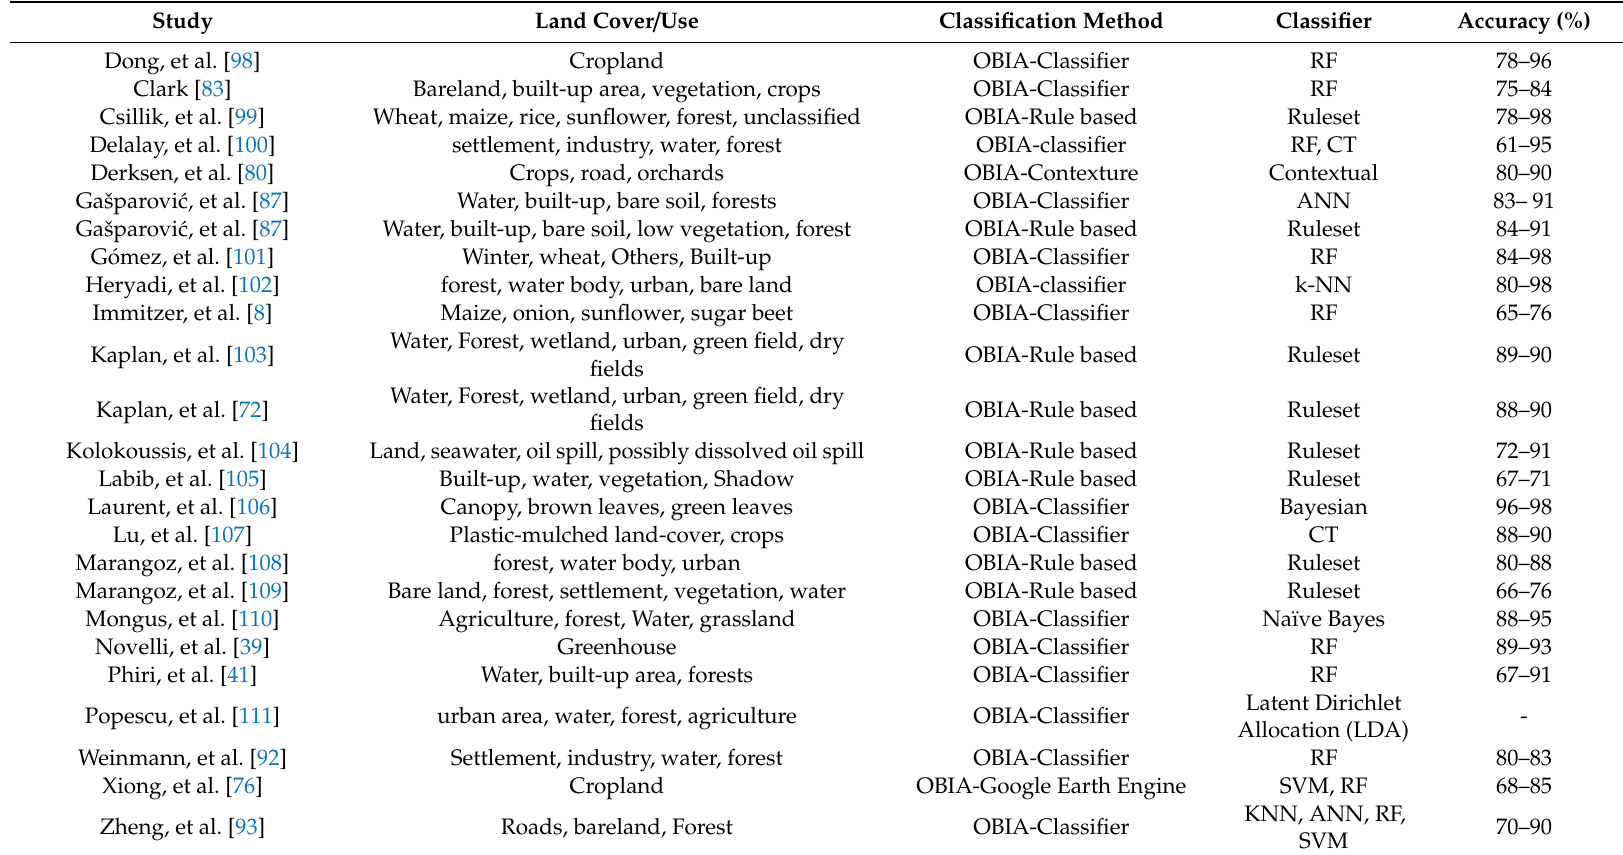
Table 4. Selected studies on the object-based land cover / use classification of Sentinel-2